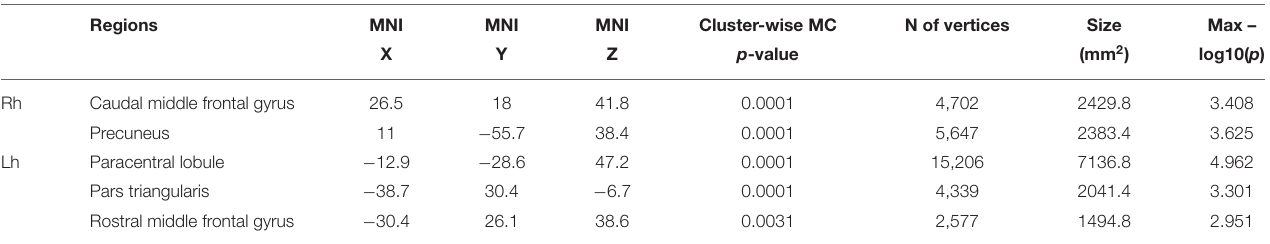
TABLE 3 | Pattern of β -amyloid cortical deposition in